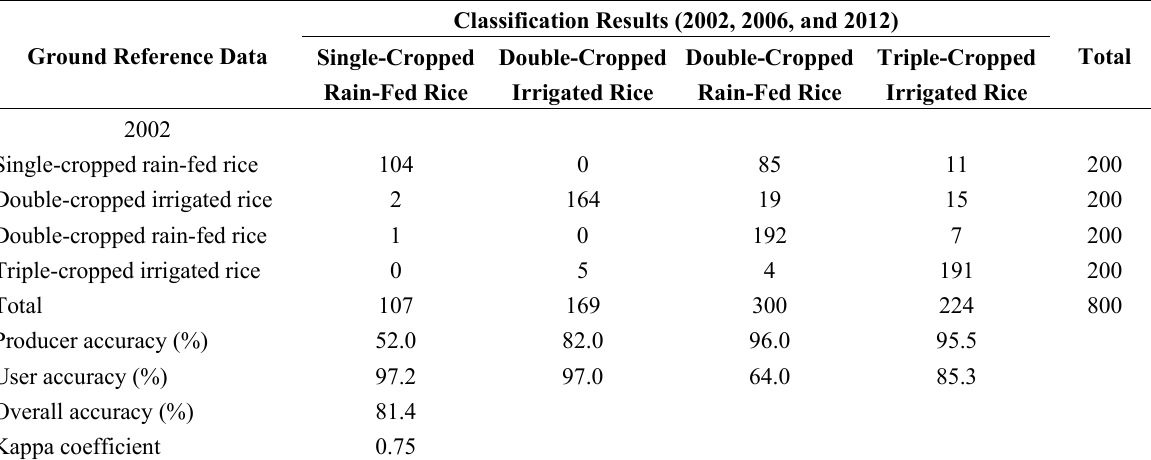
Table 1. Results of the classification accuracy